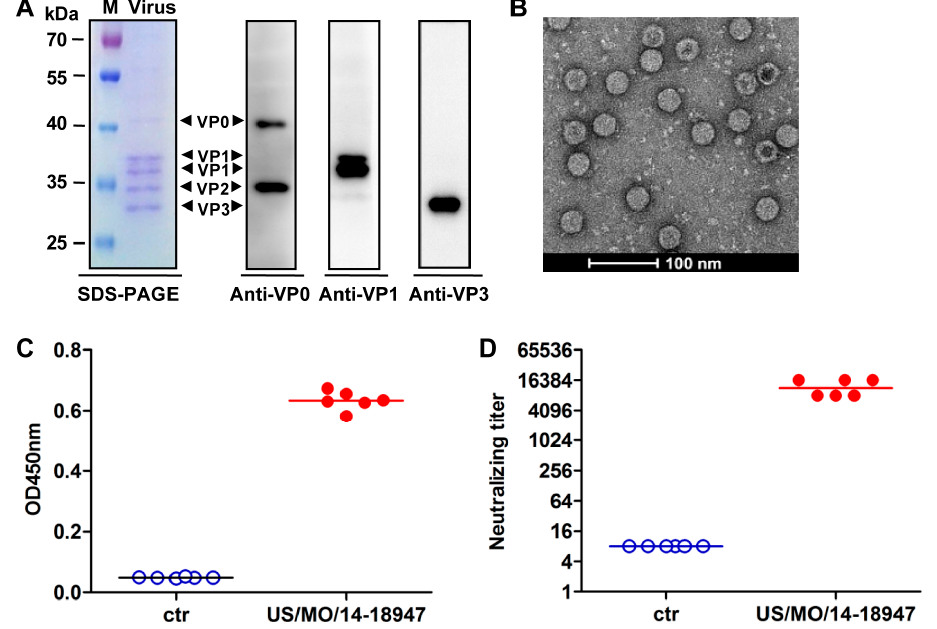
Figure 6. Neutralizing antibody responses induced by inactivated US/MO/14-18947 in adult mice. ( A ) SDS-PAGE and western blotting analysis of purified inactivated EVD68. Lane M, protein marker; lane Virus, inactivated US/MO/14-18947; ( B ) visualization of inactivated US/MO/14-18947 by electron microscopy; ( C , D ) serum antibody responses induced by inactivated US/MO/14-18947. Groups of six BALB/c mice were immunized twice with PBS (ctr) or inactivated US/MO/14-18947. Antisera were collected 2 weeks after the final immunization and used for different assays; ( C ) virus-specific antibody responses measured by ELISA with purified US/MO/14-18947 as the coating antigen. The antisera were diluted 1:1000; ( D ) neutralization titers against US/MO/14-18947. The antisera from PBS-immunized mice did not show any neutralization effect at the lowest dilution (1:16) and were assigned a titer of 8 for geometric mean titer (GMT) calculation. Each symbol represents a mouse, and the solid line indicates the geometric mean value of the group. Table 1. Cross-neutralization activity of the pooled antisera against heterologous strains and viruses. Neutralization Titer Against Pooled Antisera EVD68/ Fermon